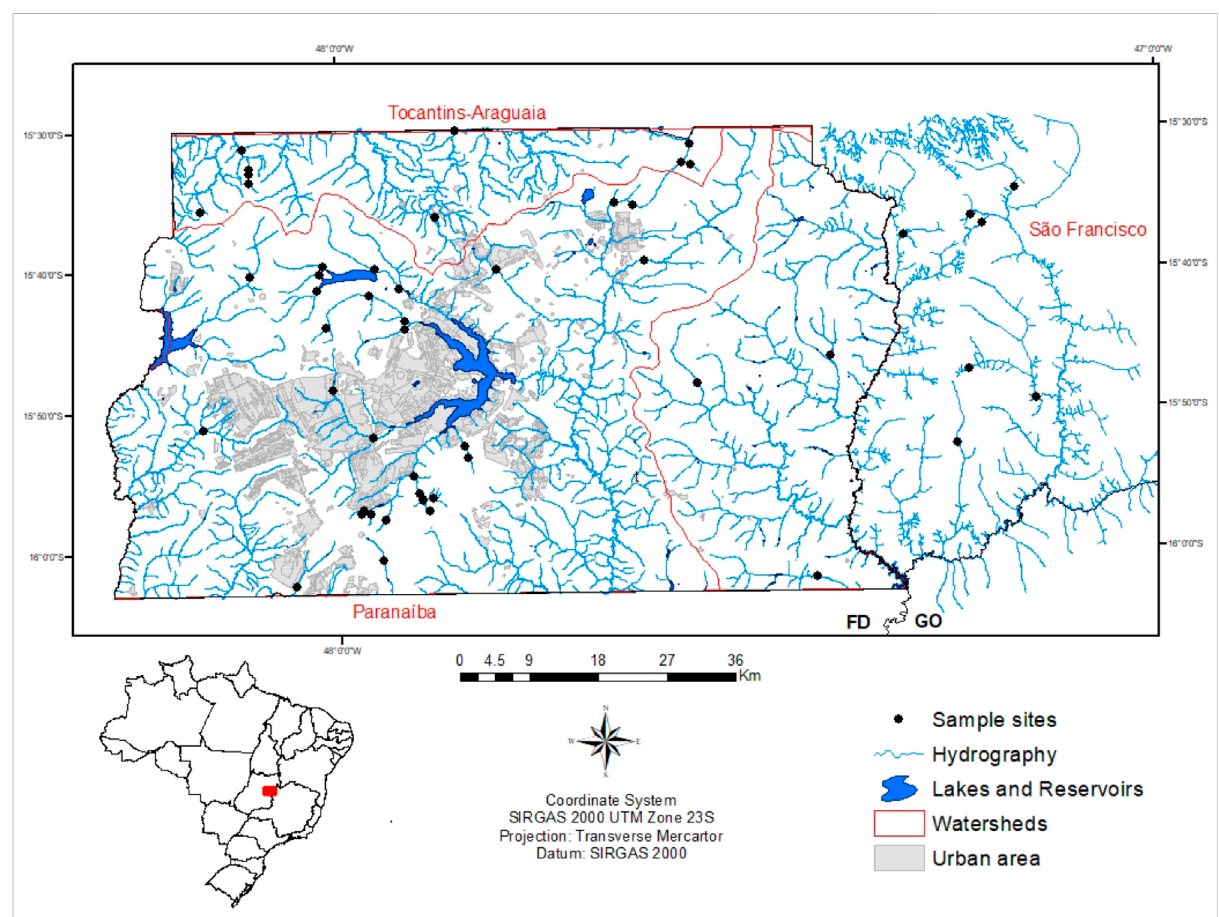
FIGURE 1 Spatial distribution of the 52 stream reaches in the regional river network. The red limits represent the portion of the national watersheds (Tocantins-Araguaia, São Francisco and Paranaíba) located in the study area (Federal District and Goiás) in central